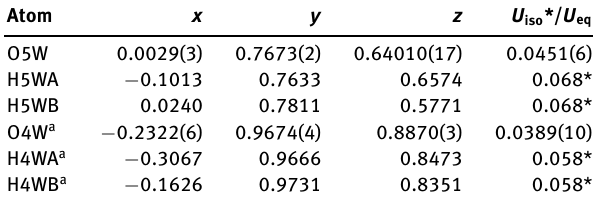
Table 2: Fractional atomic coordinates and isotropic or equivalent isotropic displacement parameters (Å 2